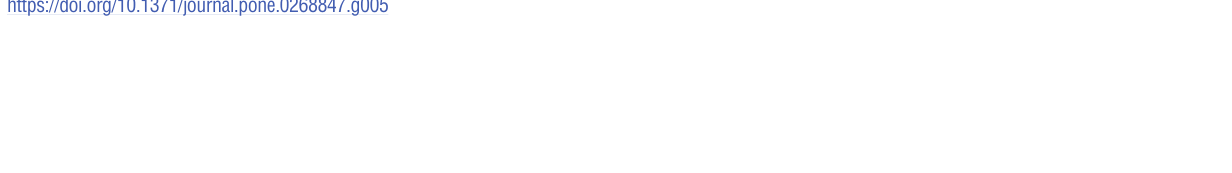
PLOS ONE | https://doi.org/10.1371/journal.pone.0268847 April 20, 2023 10 /